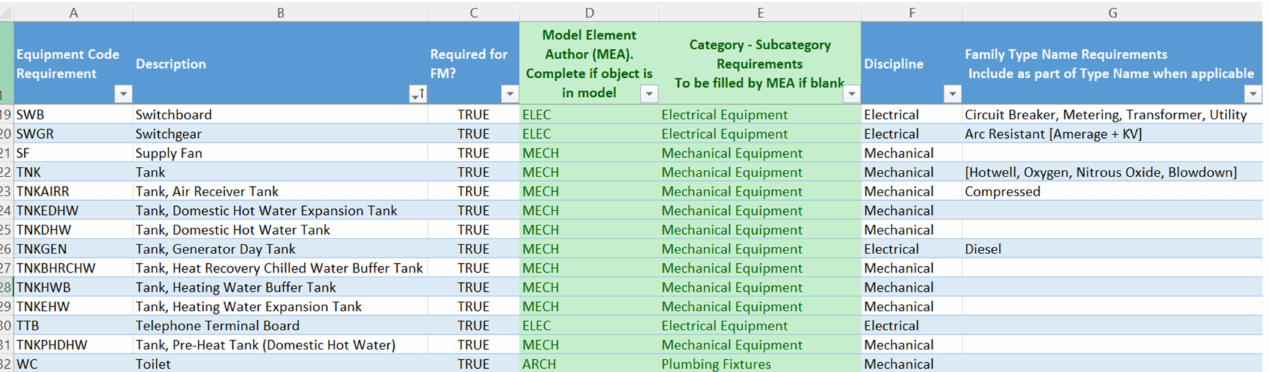
Figure 7. Partial screenshot of the Object List spreadsheet showing the required pieces of equipment to be tracked in BIM, their code, description, author, Revit category, discipline and name requirements.